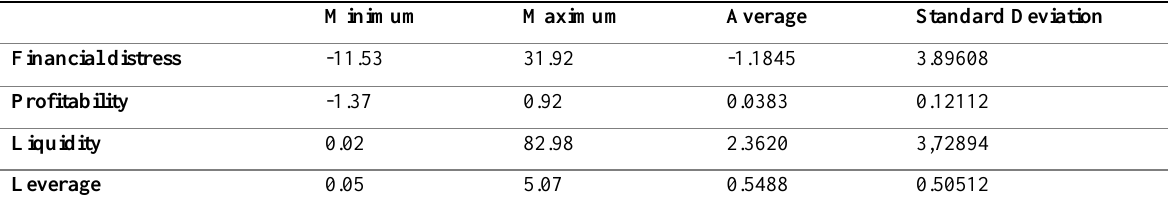
Table 1: Descriptive Statistics of Financial distress Before Covid-19